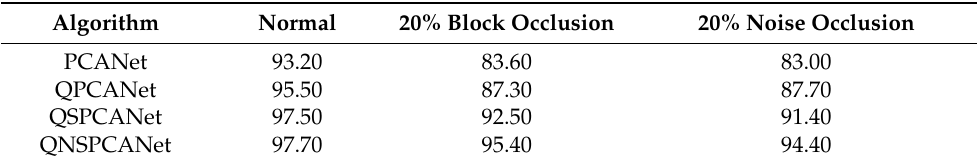
Table 1. The correct recognition rate of each algorithm in Georgia Tech dataset under different occlusion conditions (%).